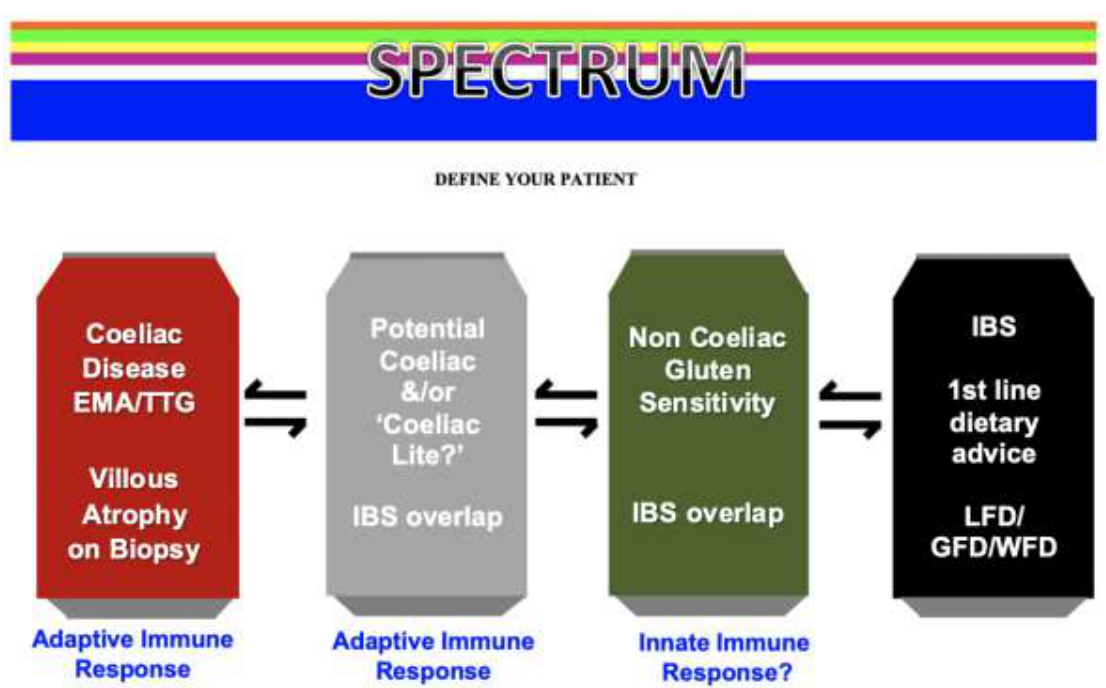
Figure 1. The spectrum of Gluten Related Disorders. EMA: endomysial antibodies; TTG: tissue transglutaminase; IBS: irritable bowel syndrome; LFD: low fermentable oligo-, di-, and mono- saccharides, and polyols diet; GFD: gluten-free diet; WFD; wheat-free diet